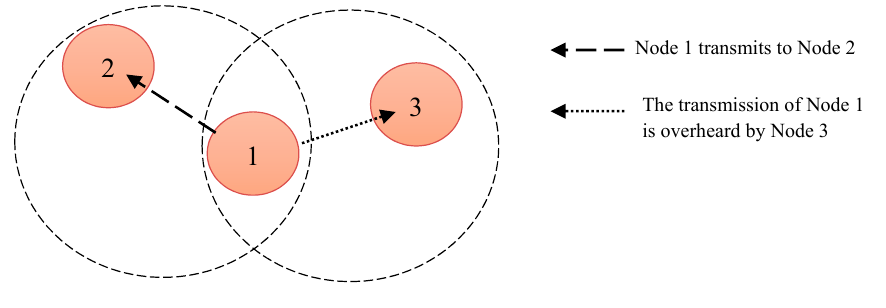
Figure 2. Simple MANET topology.